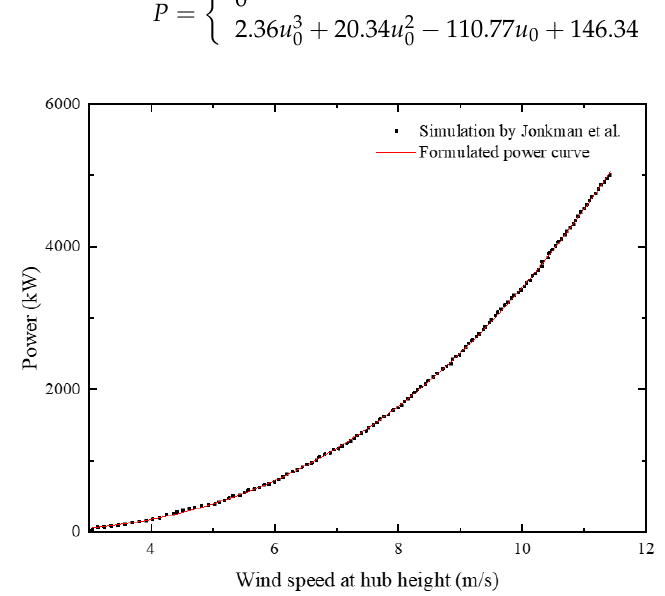
Figure 3. Power curve of the NREL 5 MW wind turbine.